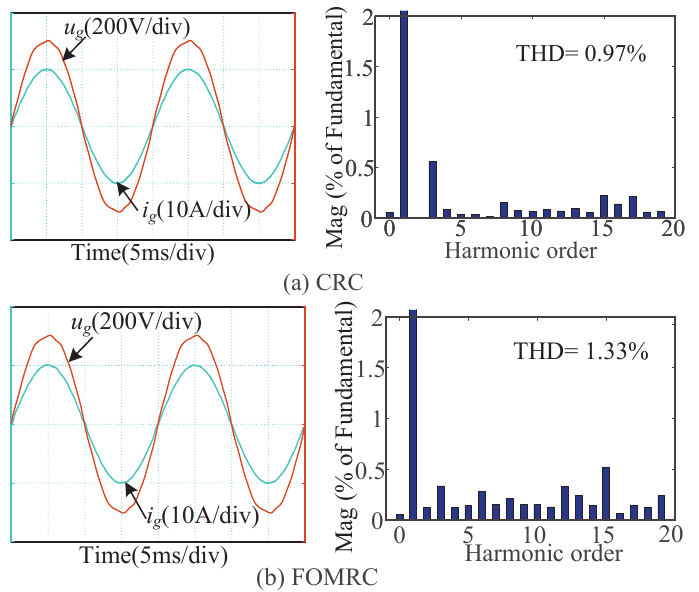
Figure 8. Voltage and current waveforms and output current spectrum of the two control systems with integer delay ( f g = 50